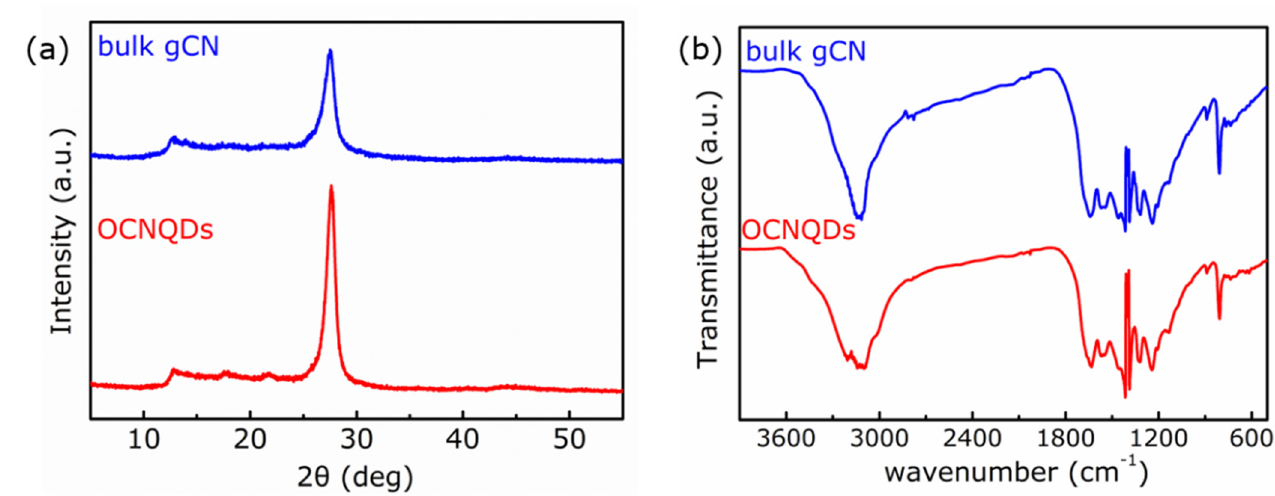
Figure 3. ( a ) The XRD diagrams; ( b ) the FT-IR spectra of bulk gCN and OCNQDs.